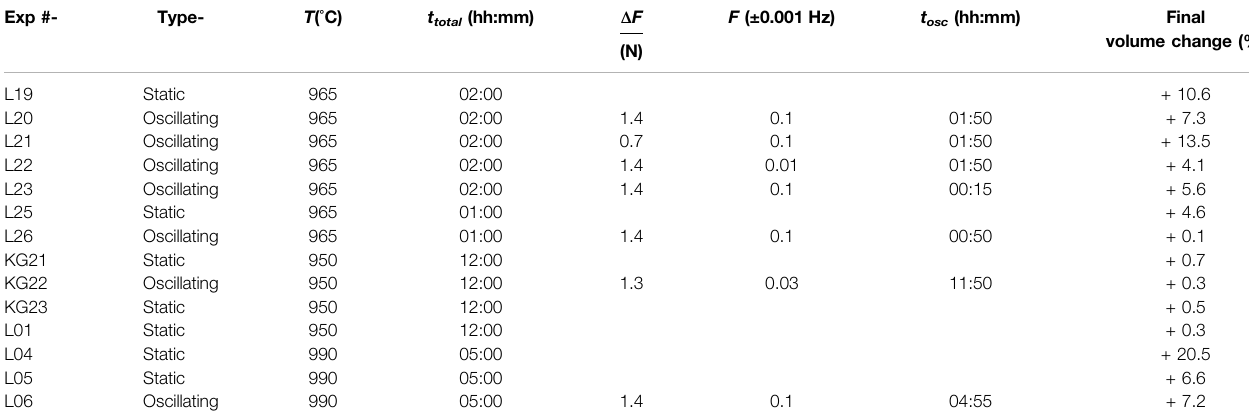
TABLE 3 | Summary of experimental conditions. T is temperature, t total is the total time spent at isotherm temperature, Δ F is the oscillation amplitude, f is the oscillation frequency and t osc is the duration of oscillation. For the fi nal volume change, + symbol indicates an increased in volume (i.e., sample expansion).